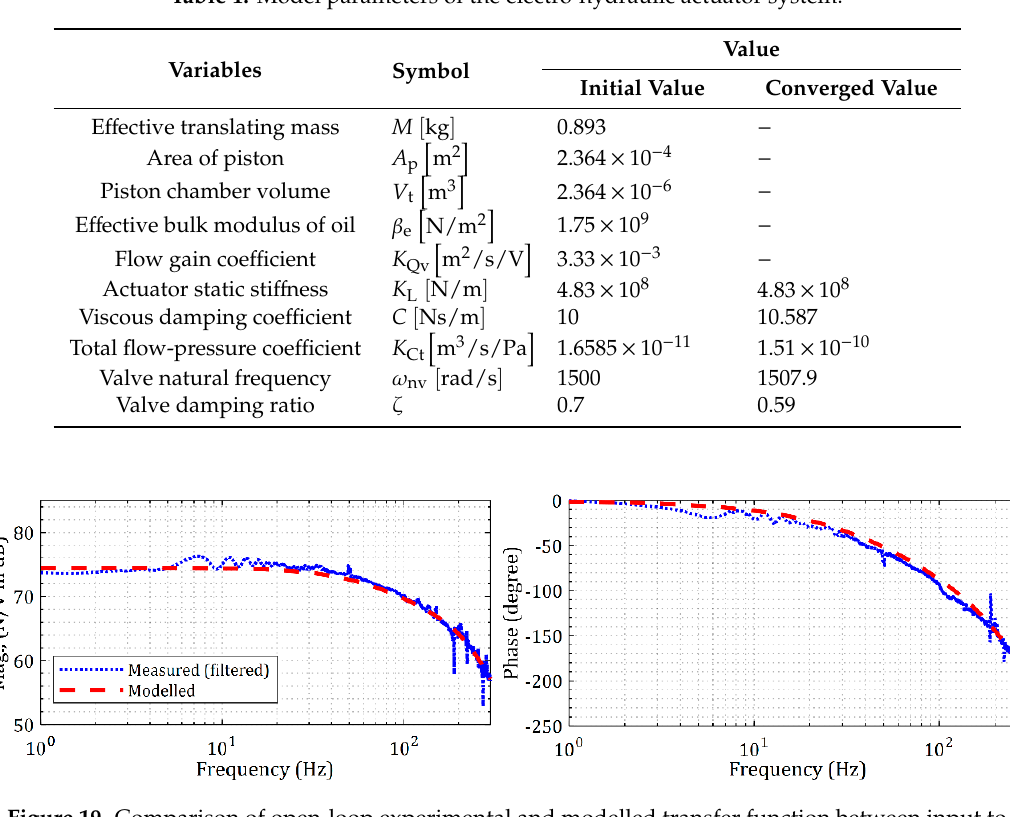
Figure 19. Comparison of open-loop experimental and modelled transfer function between input to the valve and actuator output force.